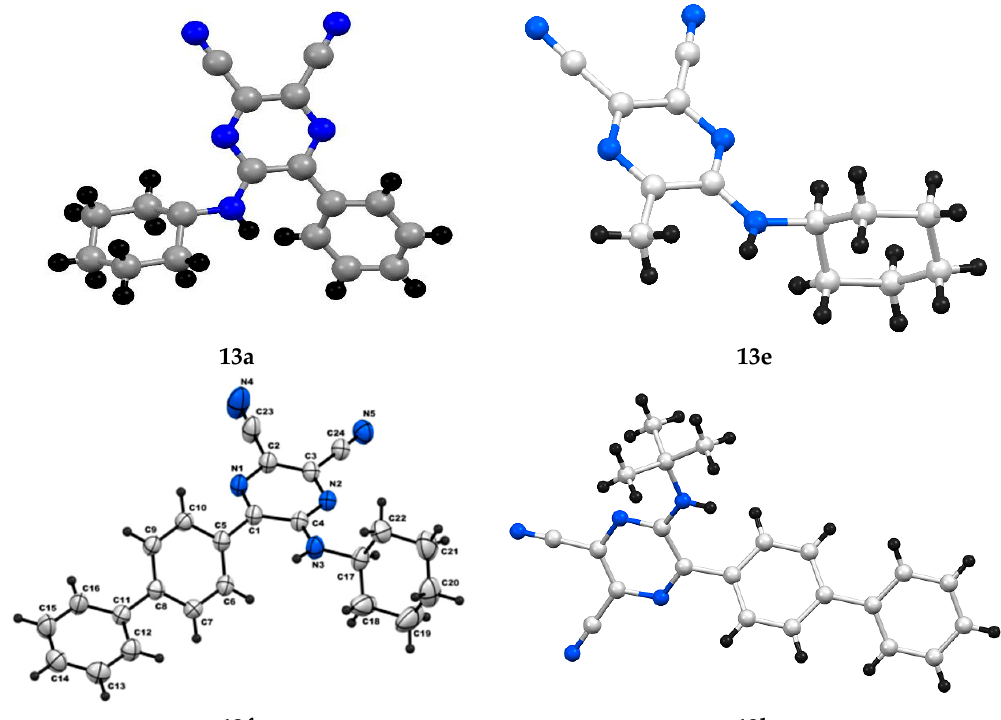
Figure 4. X-ray crystal structures of pyrazines 13a, e, f, and k.